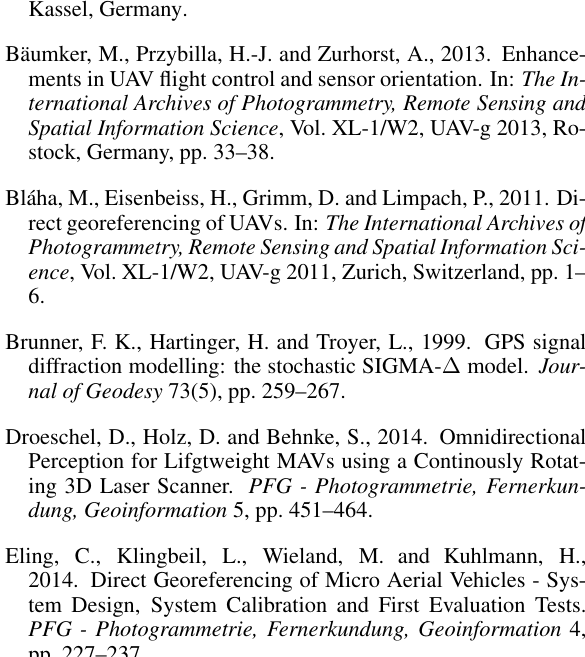
Figure 7. Differences of the determined up coordinates to the reference solution for the original (top) and modified (bottom) data set. The black circles in the bottom panel mark points where satellites were excluded by applying the determined OAEMs.